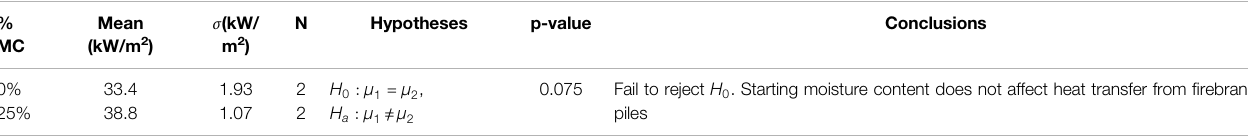
TABLE 7 | Summary of the statistical analysis of the effect of starting moisture content of unburned fi rebrands on the heat transfer from fi rebrand piles.